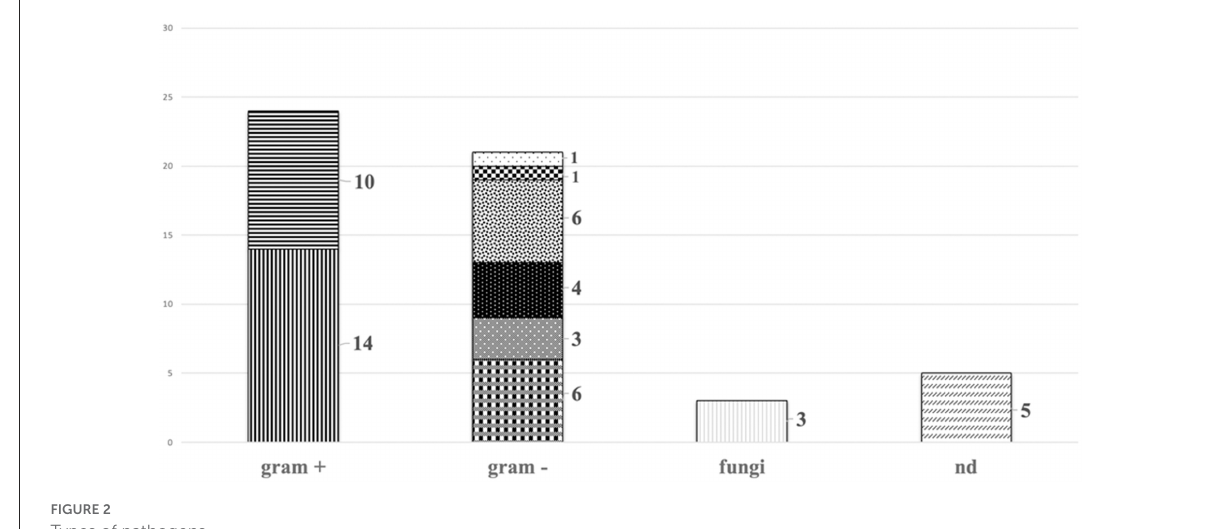
FIGURE2 Types of pathogens.